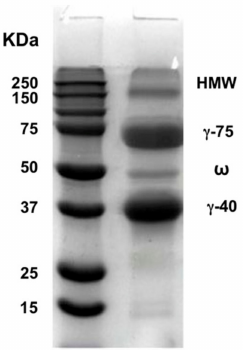
Figure 1. SDS-PAGE pattern of extracted